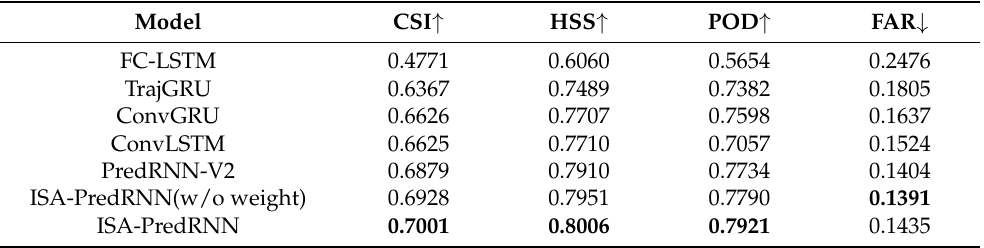
Table 1. Comparison of the experimental results at the level of 10 dBZ.